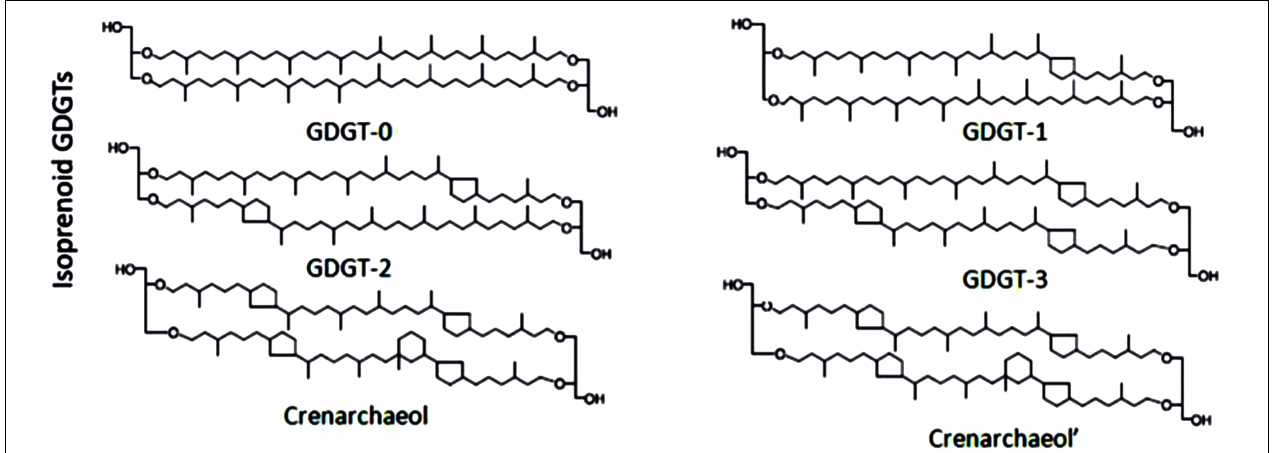
FIGURE 1 | Molecular structure of isoprenoid glycerol dialkyl glycerol tetraethers